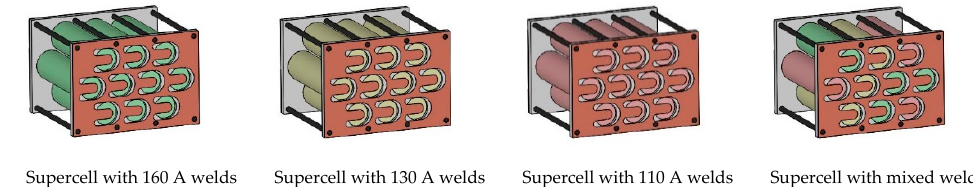
Figure 6. Supercells joined with 160 A, 130 A, 110 A, and a mixture of welding currents.